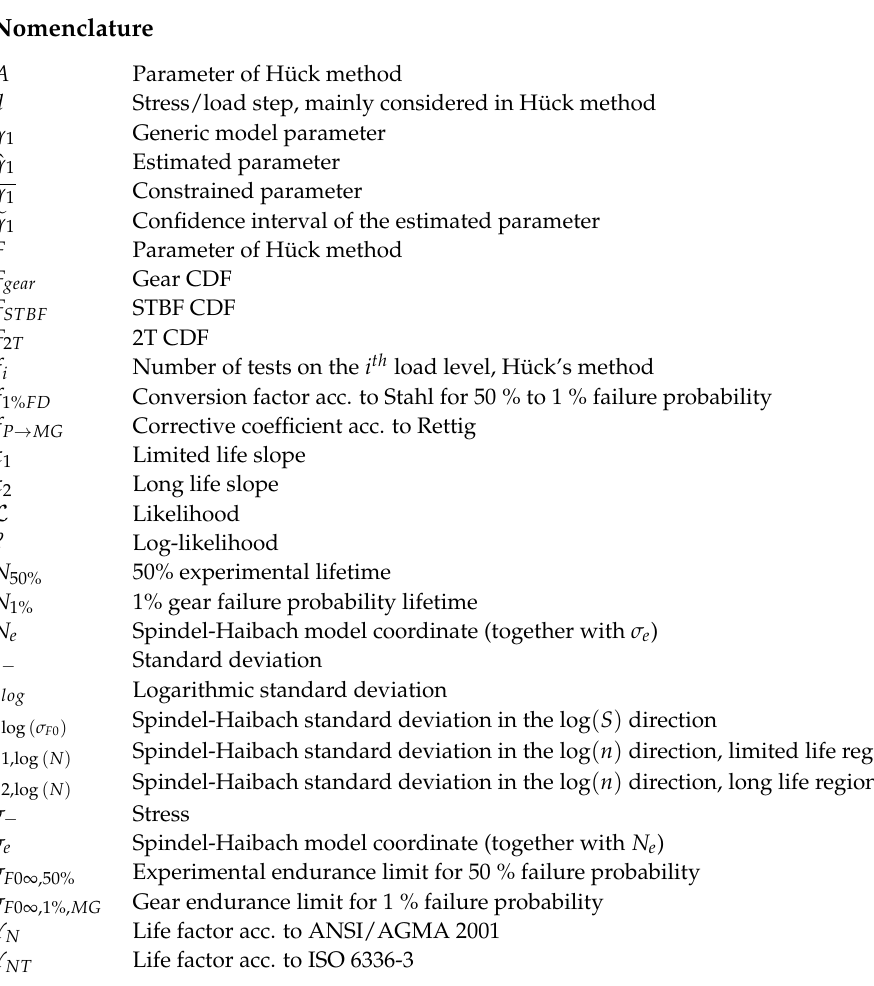
Figure A1. Example of LP and LR for 𝑠 𝑙𝑜𝑔(𝜎 𝐹0 ) . The usage of PF allows for the description of the confidence interval of the parameter in its natural range [61,63,64] via the usage of the Likelihood Ratio (LR). It is possible to demonstrate that the ratio between ℓ̂ and ℓ 𝛾̅ 1 can be related to a 𝜒 2 distribution with one degree of freedom